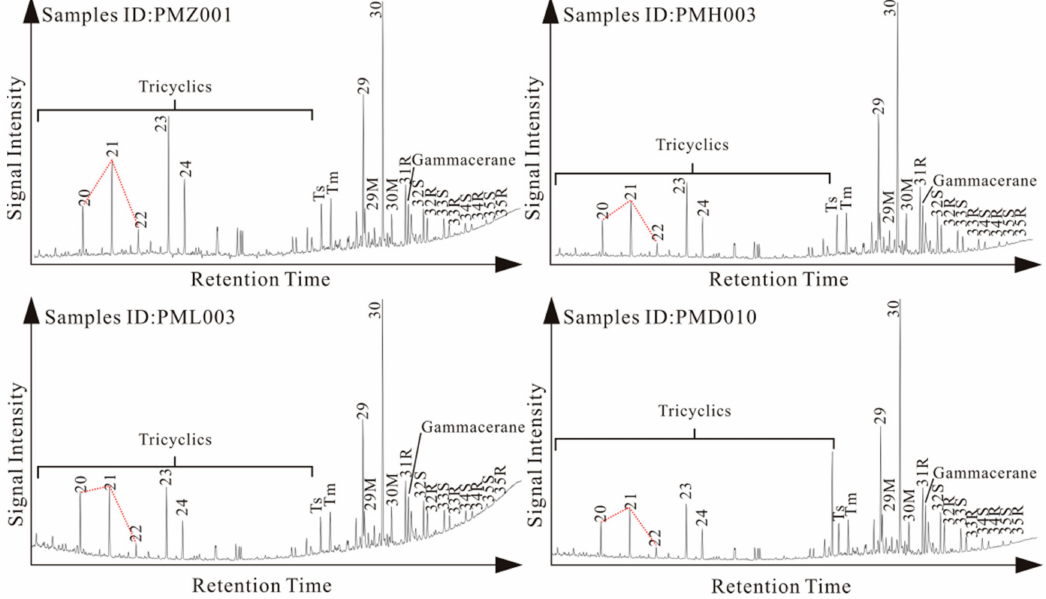
Figure 6. M/z191 mass fragment grams of saturated hydrocarbon